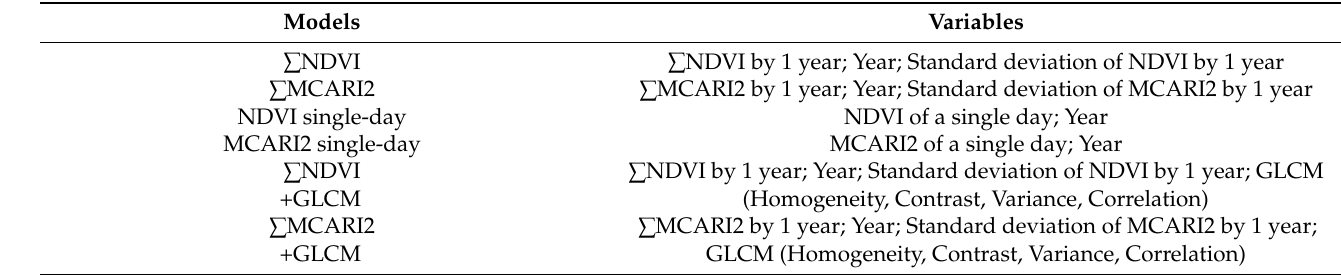
Table 3. Variables observed in the developed PCA and clustering analysis on studied models.